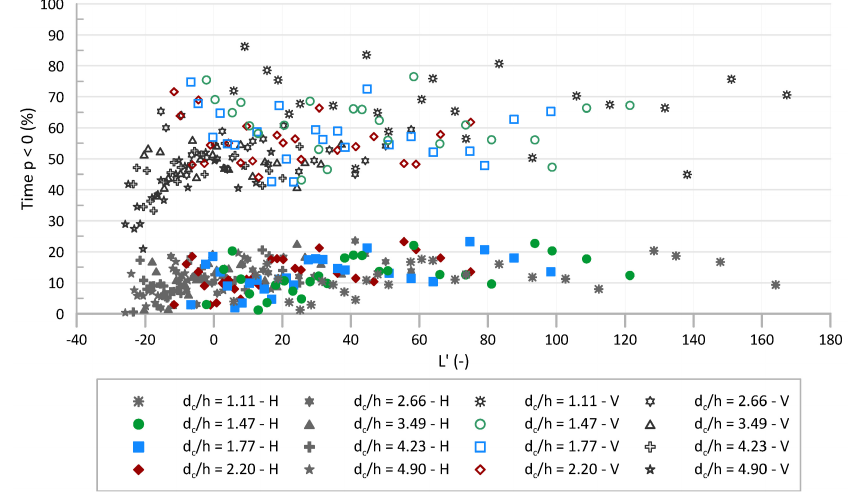
Figure 6. Streamwise development of the percentage of total time during which the taps located near the outer edge of the vertical face of the steps (z/h = 0.133, unfilled symbols) or near the outer edge of the horizontal face of the steps (y/l = 0.178, filled symbols) exhibit negative pressures. Data for the LOH II stepped